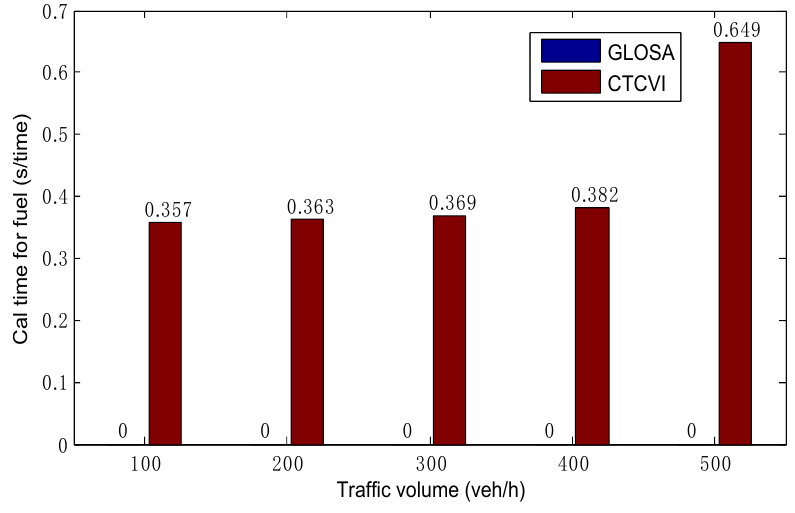
Figure 12. Comparison of calculation time in the optimization of fuel